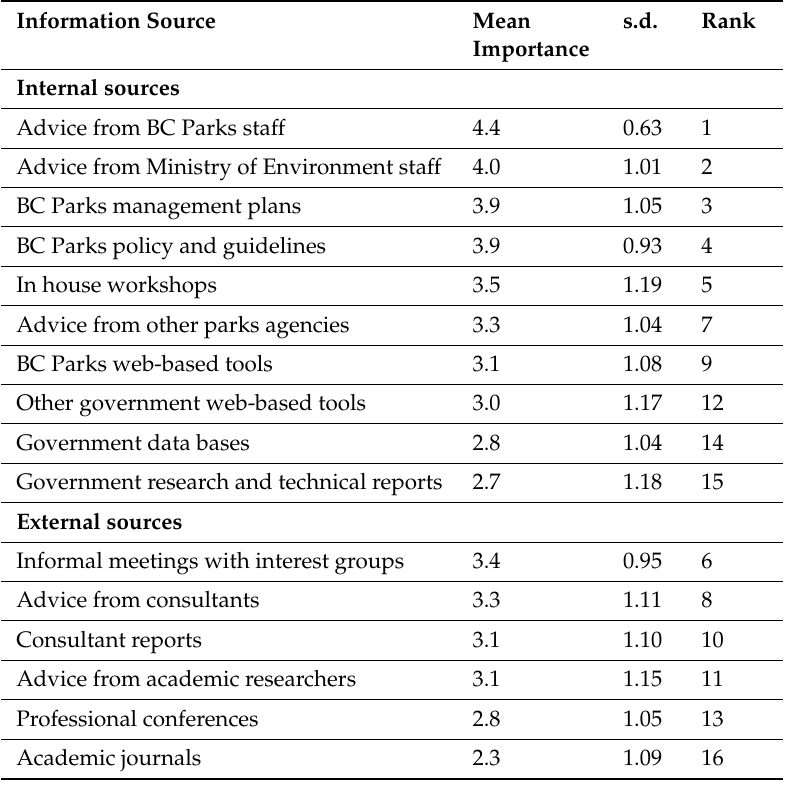
Table 1. Mean importance rankings of internal and external information